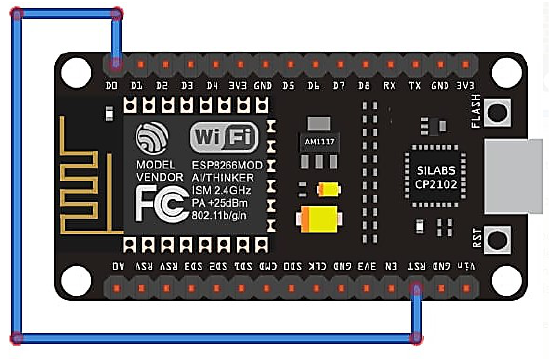
Figure.3. Connection for deep sleep